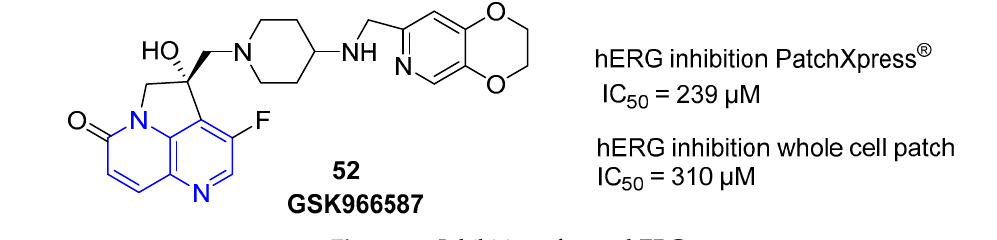
Figure 12. Inhibition of 52 on hERG.